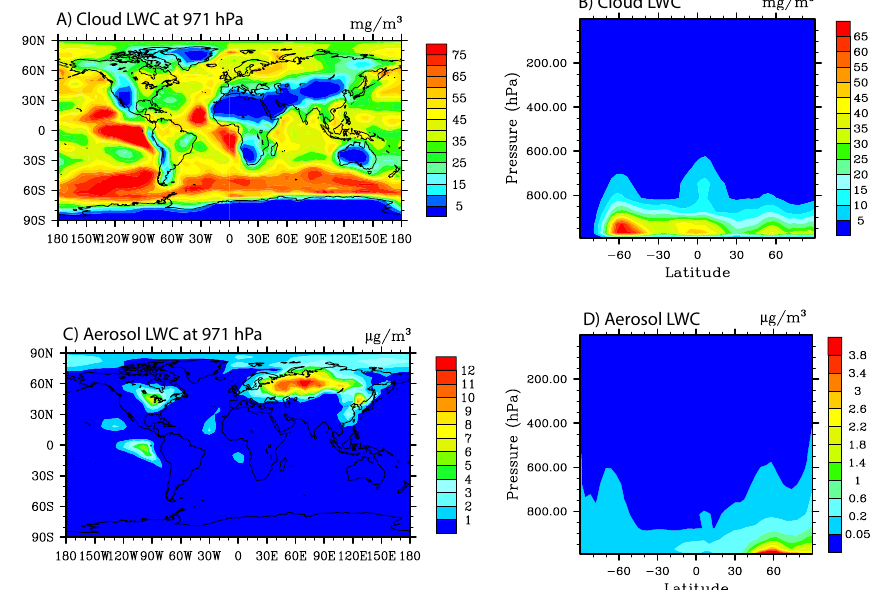
Figure 2. Annual mean grid-box averaged cloud liquid water content (LWC) in mgm − 3 at approximately 971hPa (A) and zonal mean content (B) , and annual mean aerosol LWC in µgm − 3 at approximately 971hPa (C) and zonal mean content (D) . Plots are for Case 1, but are the same for all cases except Case 4 (compare Fig. 4).